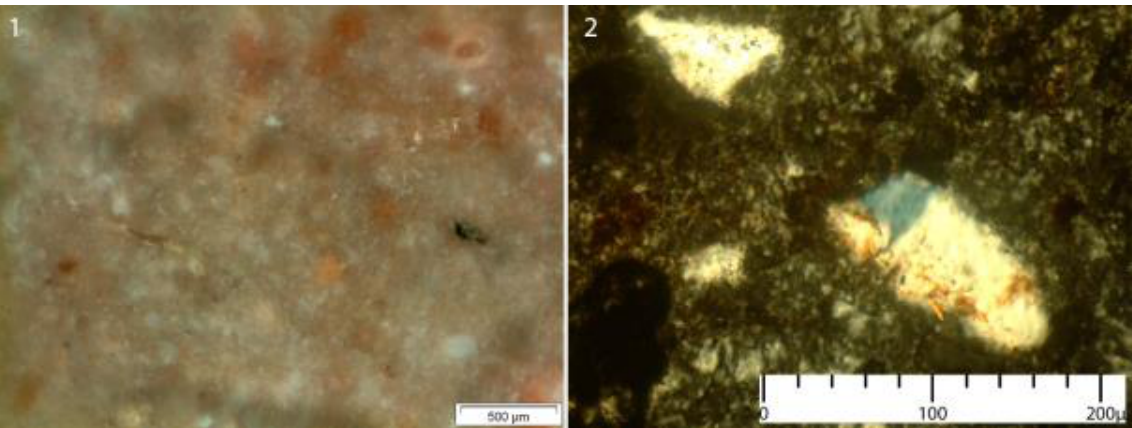
Figure 7. Oxfordian flints’ macro and microscopic textures and constituents; Genetic Type J3-2: 1. General texture (scale bar = 500 µm); 2. Detrital quartz embedded in the siliceous matrix (scale bar = 200 µm).